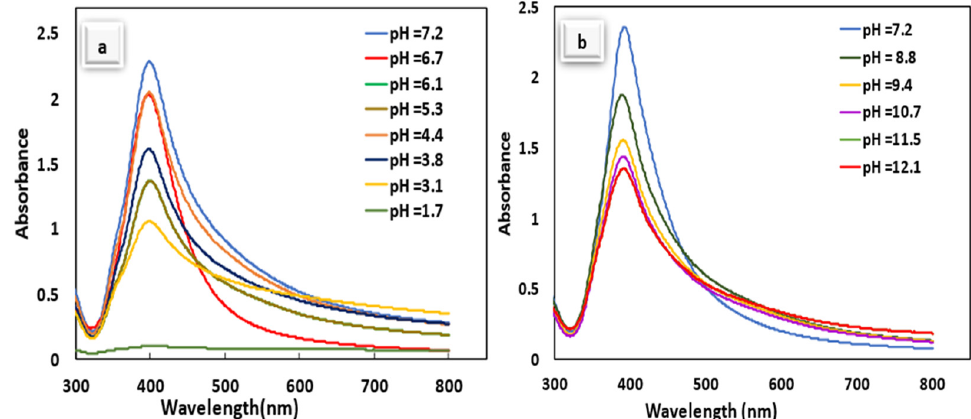
Figure 3. UV-Vis data collected across the pH range produced by adding HCl, 0.1 M ( a ) or NaOH, 0.1 M ( b ) to aqueous AgNP functionalized by Teucrium apollinis extract. The SPR shifting from 397 nm at pH = 7.2 to 408 nm and 401 nm at pH 3.1 and pH 12.1, respectively. pH Study of the Stability of Teucrium Apollinis-AgNPs- in Acid and Basic Conditions of 0.1 M HCl and 0.1 M